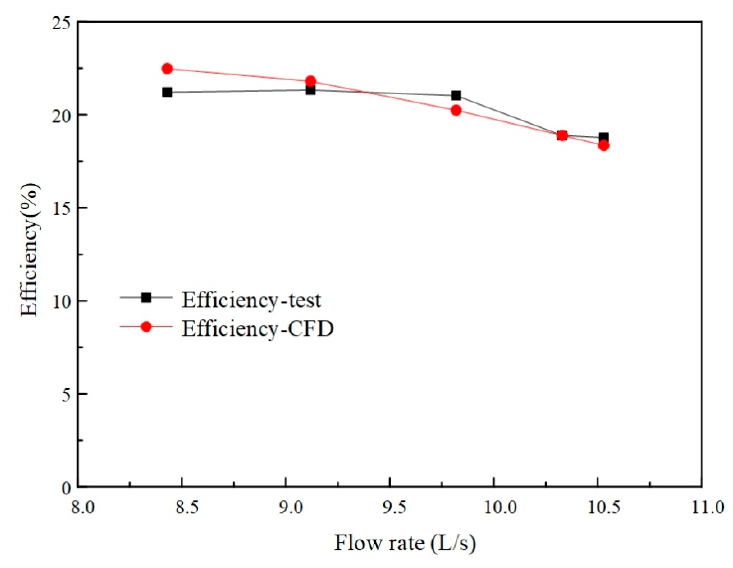
Figure 4. Comparison of the efficiency between tests and numerical calculations.